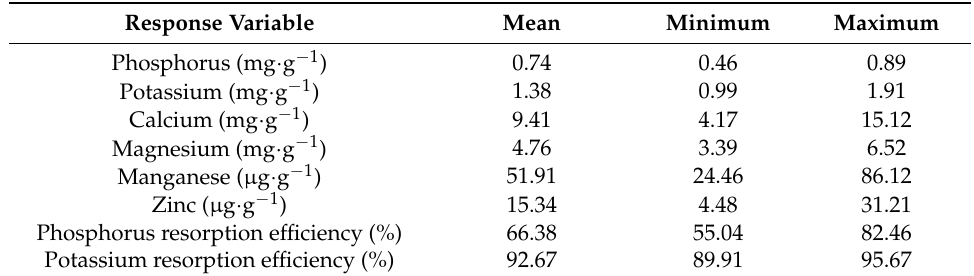
Table 4. Senesced leaf elemental response variables that were not influenced by Cycas micronesica tree height in Yap schist